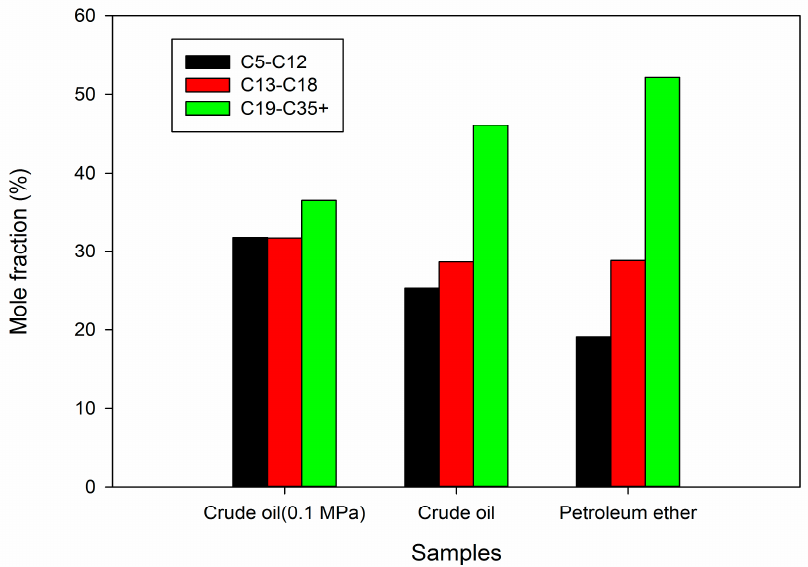
Figure 5. Mole fractions of hydrocarbons after the crude oil diluted with petroleum ether and undiluted crude oil at the pressure of 30 MPa.